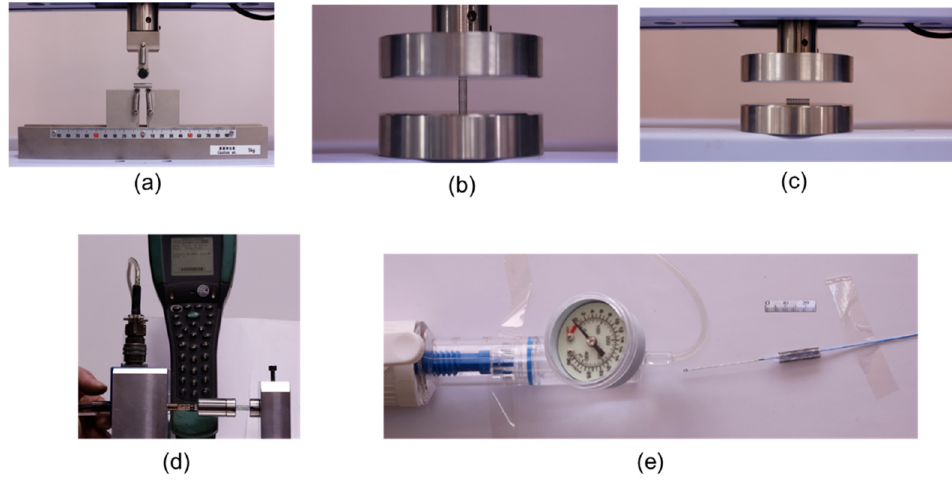
Figure 3. Mechanical testing set-up to perform ( a ) three-point bending; ( b ) longitudinal compression; ( c ) lateral compression; ( d ) torsion and ( e ) radial expansion.